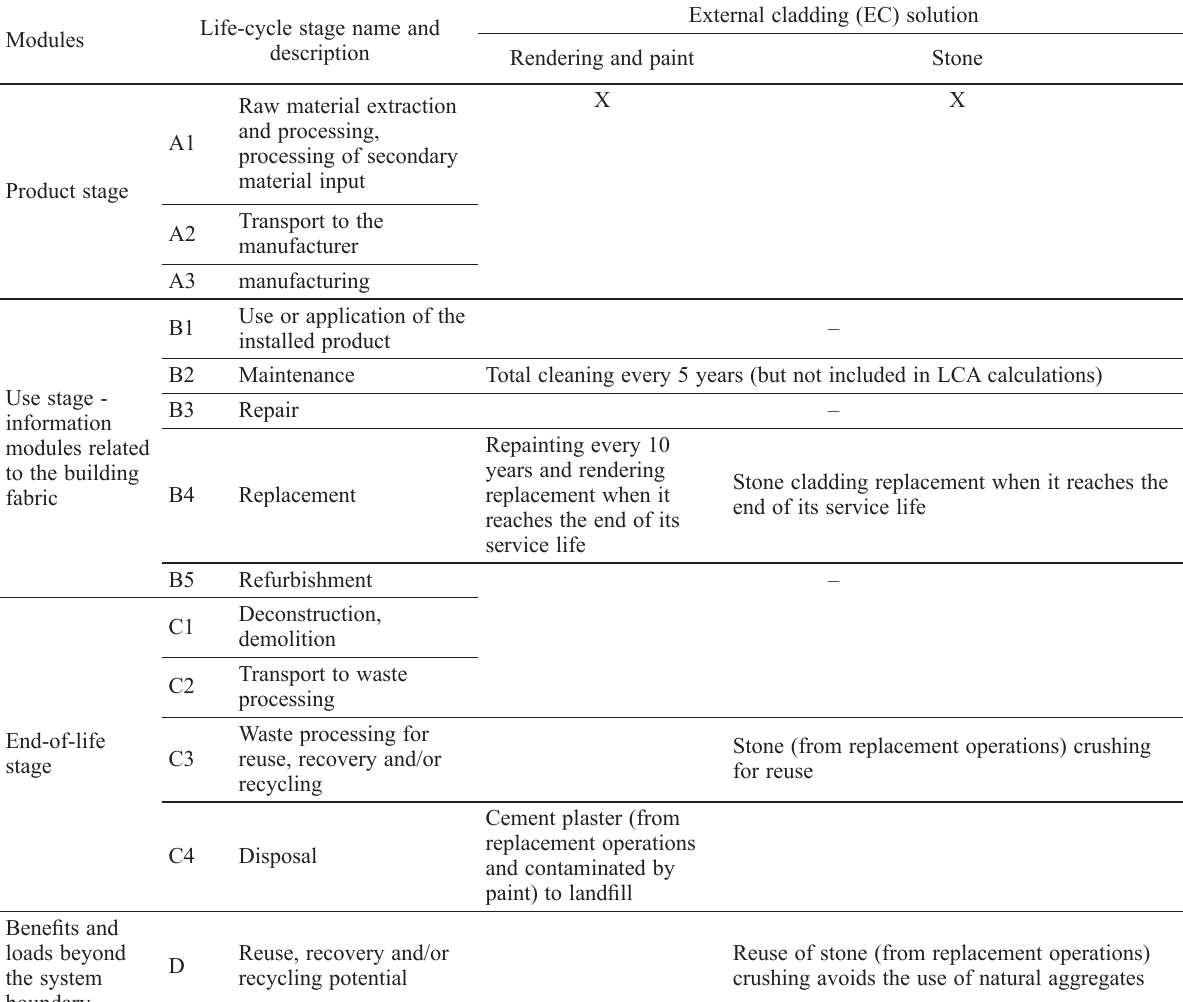
table 7. life cycle stages (taken from european standards) considered in lCA calculations for the two external wall claddings (FpreN 15804:2011 (2011)) external cladding (eC) solution life-cycle stage name and Modules description rendering and paint